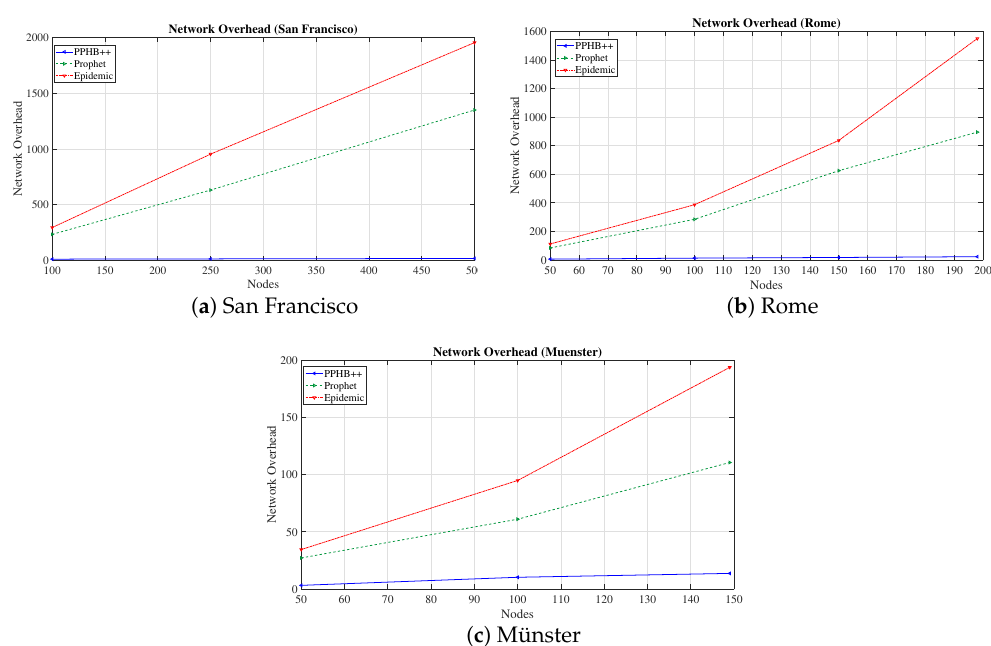
Figure 5. Network overhead (NetO) for the three cities of San Francisco, Rome, and Münster. In Münster, the best MDP is delivered by the Prophet algorithm, then the PPHB++ and Epidemic algorithms. The Prophet algorithm yields a better result than PPHB++ (11.2193%) and Epidemic (25.9318%) in terms of MDP. Furthermore, Figure 3 supports the results in Table 3; in San Francisco, the MDP is between 23% and 81% due to a large number of active taxis with an extensive range of movement; in Rome, it is lower and between 6% and 10% because the number of active taxis and the mobility are smaller; in Münster, this value is between 7% and 8% because the type of node is changed to bus. Consequently, the number of buses is smaller than the other two previous scenarios, and their movement range in the city is